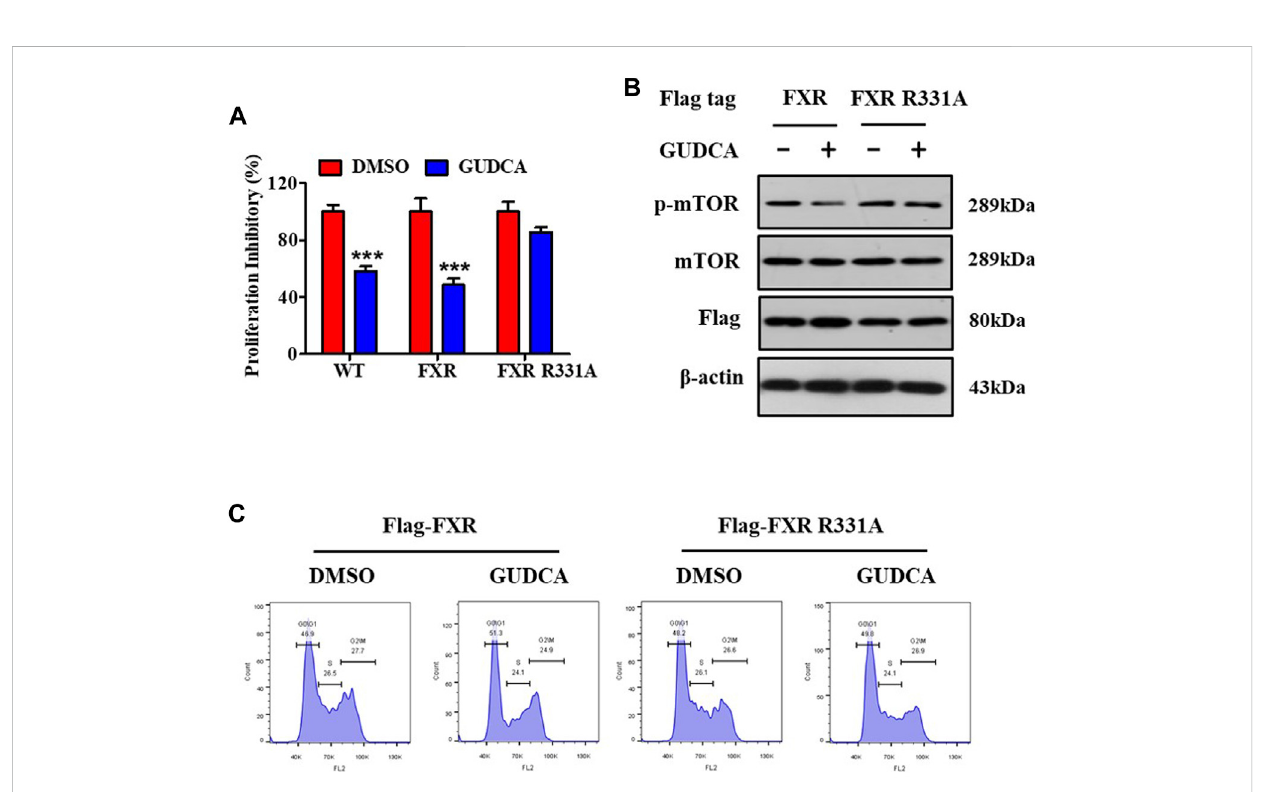
dependent manner (Supplementary Figure S7). A reporter assay revealed that GUDCA suppressed the CDCA-induced transcriptional activity of FXR (Figure 4E). Furthermore, FXR mutant data showed that FXR R331 affected the effect of GUDCA on FXR transcriptional activity (Figure 4F).